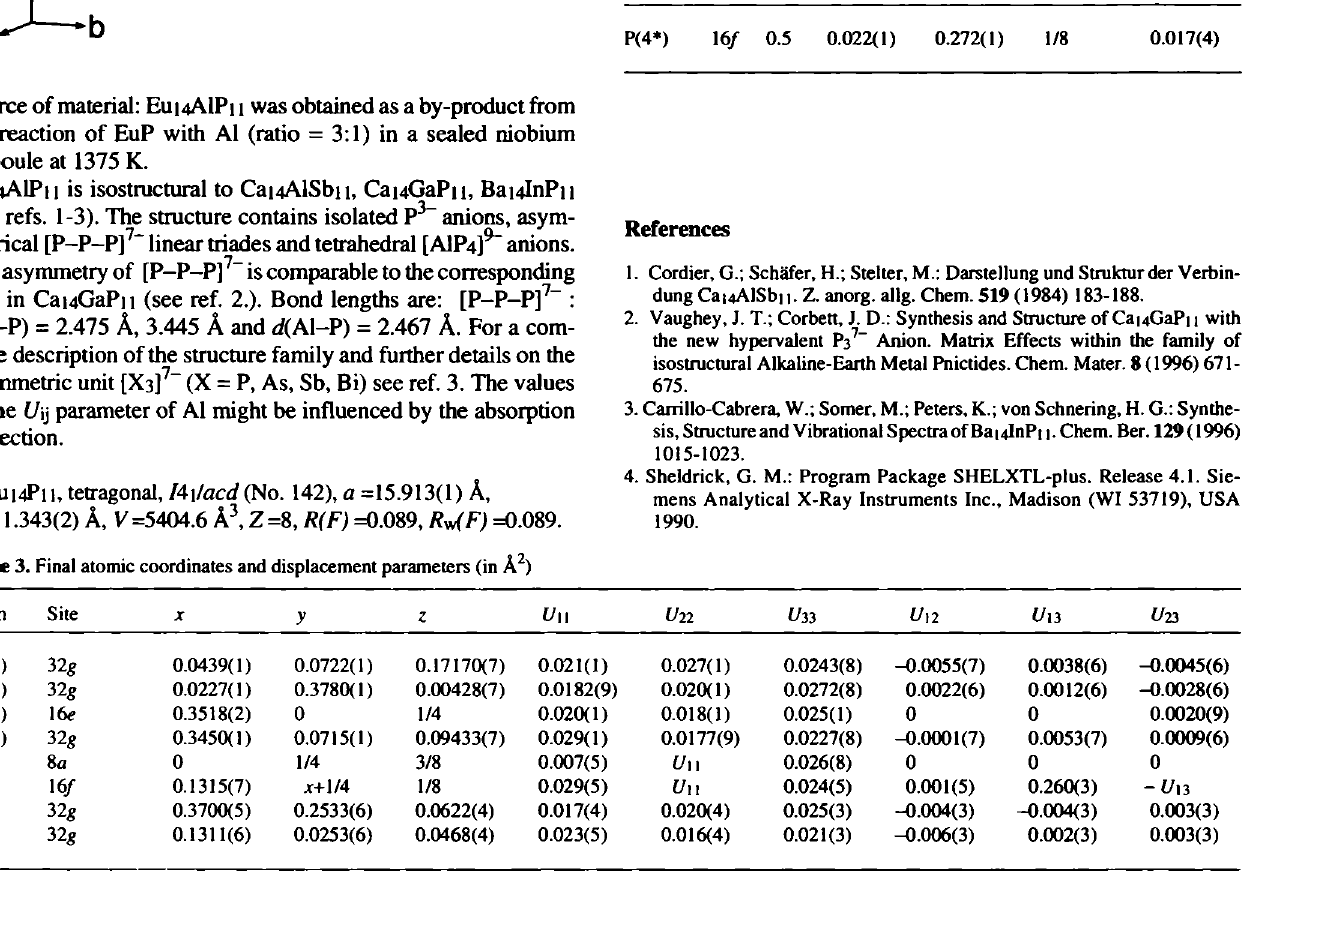
Table 1. Parameters used for the X-ray data collection